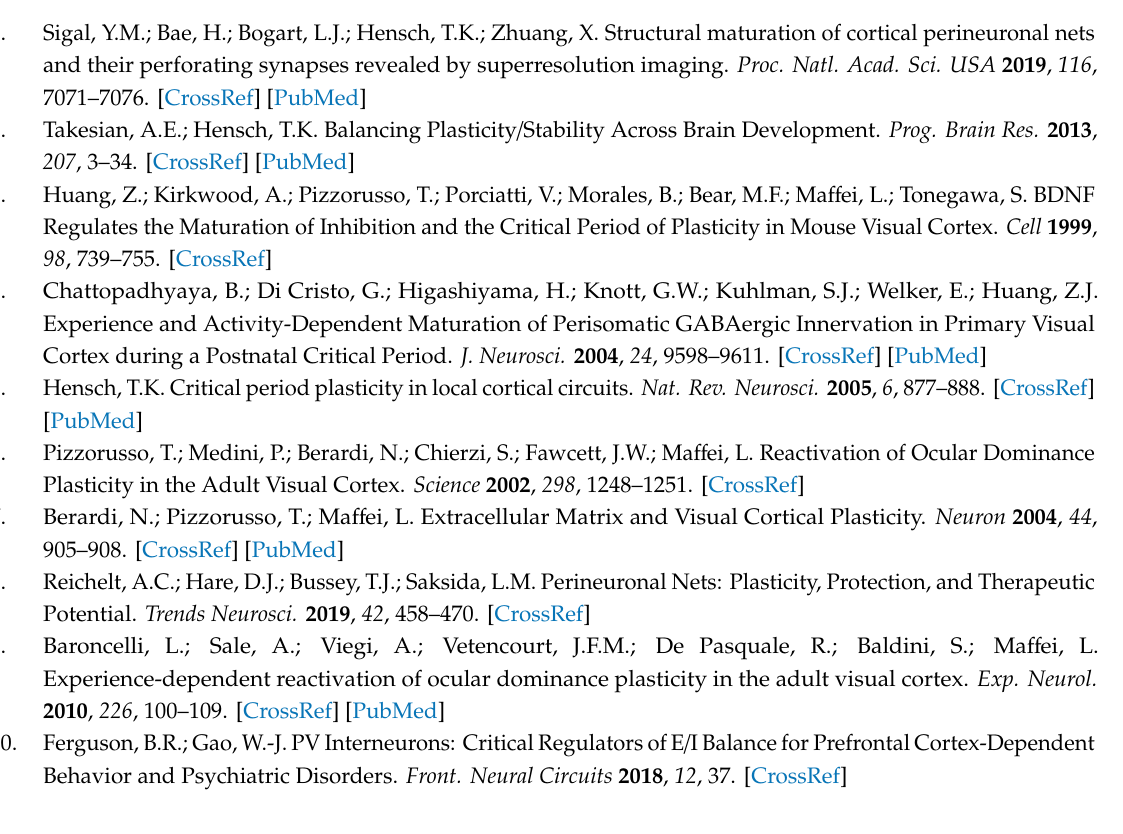
Figure S1: The expression level of chondroitin sulfate proteoglycans was hardly a ff ected by the loss of E